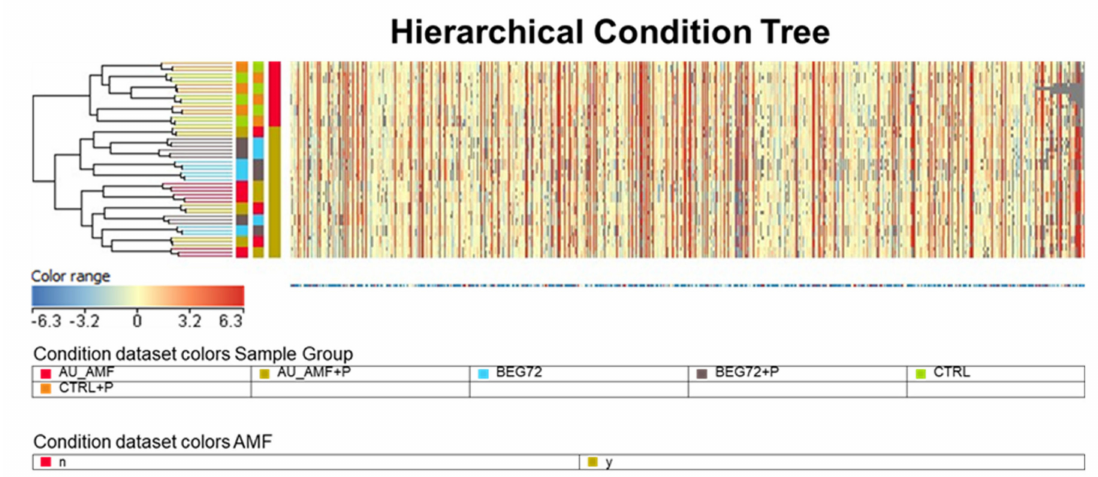
Figure 3. Unsupervised hierarchical clustering (Euclidean distance, linkage rule: Ward’s) carried out on the metabolomic profile of loquat plants following the AMF inoculation and infection by Armillaria mellea . The fold-change-based heat map was used to produce the clusters. AMF inoculation represented the hierarchically more relevant factor for